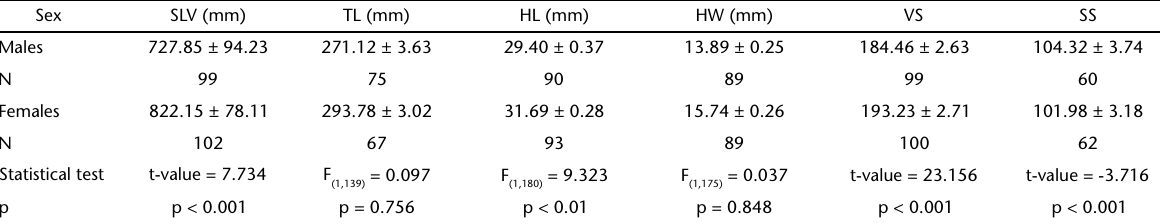
Table I. Sexual dimorphism in SVL, tail length (TL), head length (HL), head width (HW), ventral scales (VS) and subcaudal scales (SS) for adult Mastigodryas boddaerti from Amazon and Cerrado populations. Means ± sd. Sexual differences in SLV, VS and SS were tested using Student t test and sexual differences in TL, HL and HW were tested using ANCOVA.